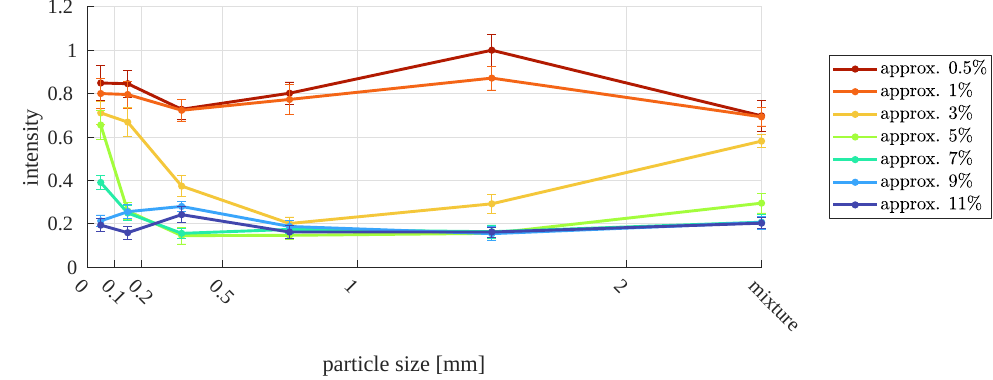
Figure 19. Image median intensity as function of particle size, for different relative moistures.